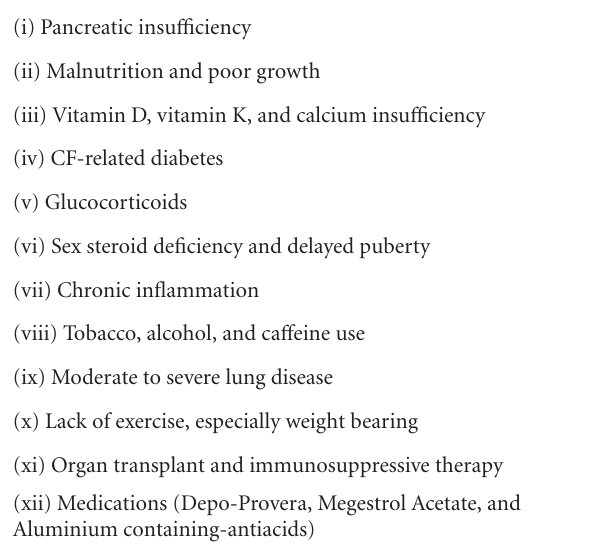
Table 1: Causes of decreased bone density in cystic